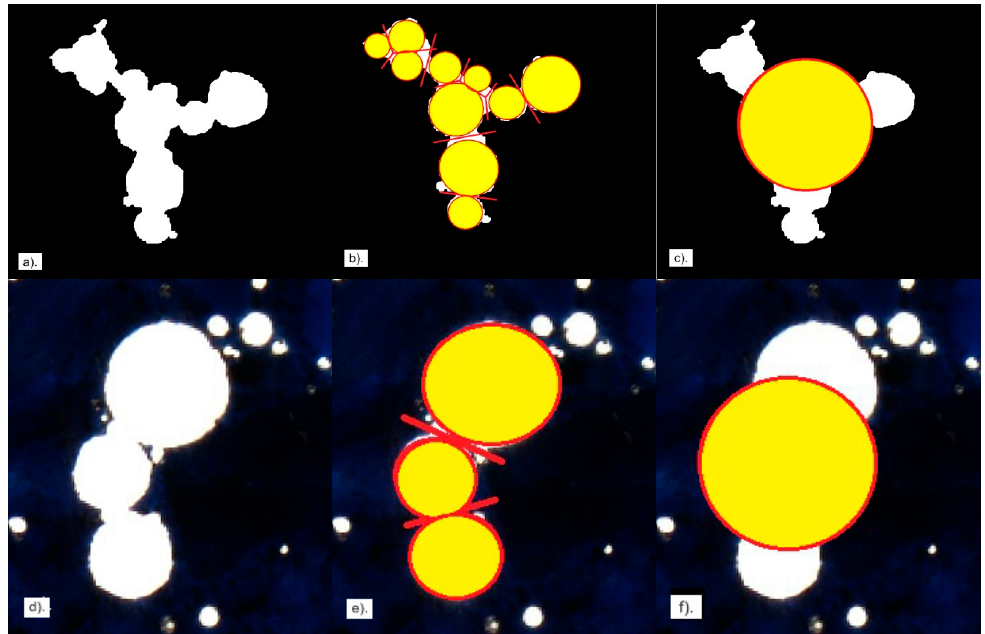
Figure 2. Examples of air void grouping ( a , d ) connected air voids, ( b , e ) breakup of agglomerated air voids, ( c , f ) an individual air void having equivalent diameter.